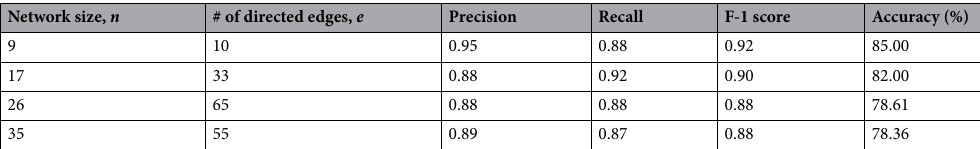
Table 1. Network configuration (number of nodes, directed edges), the number of directed edges in each synthetic true network, precision, recall, F-1 score, and